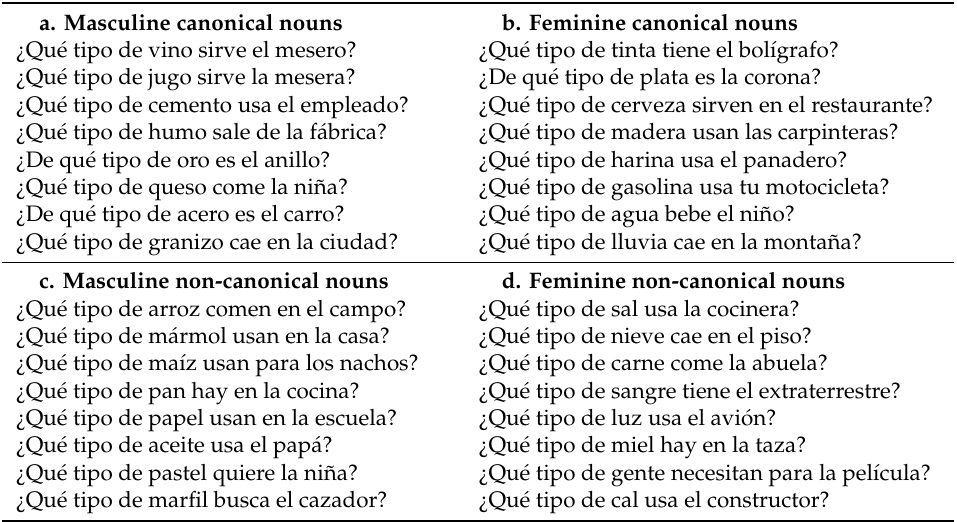
Table A2. Test items in each condition. b. Feminine canonical nouns